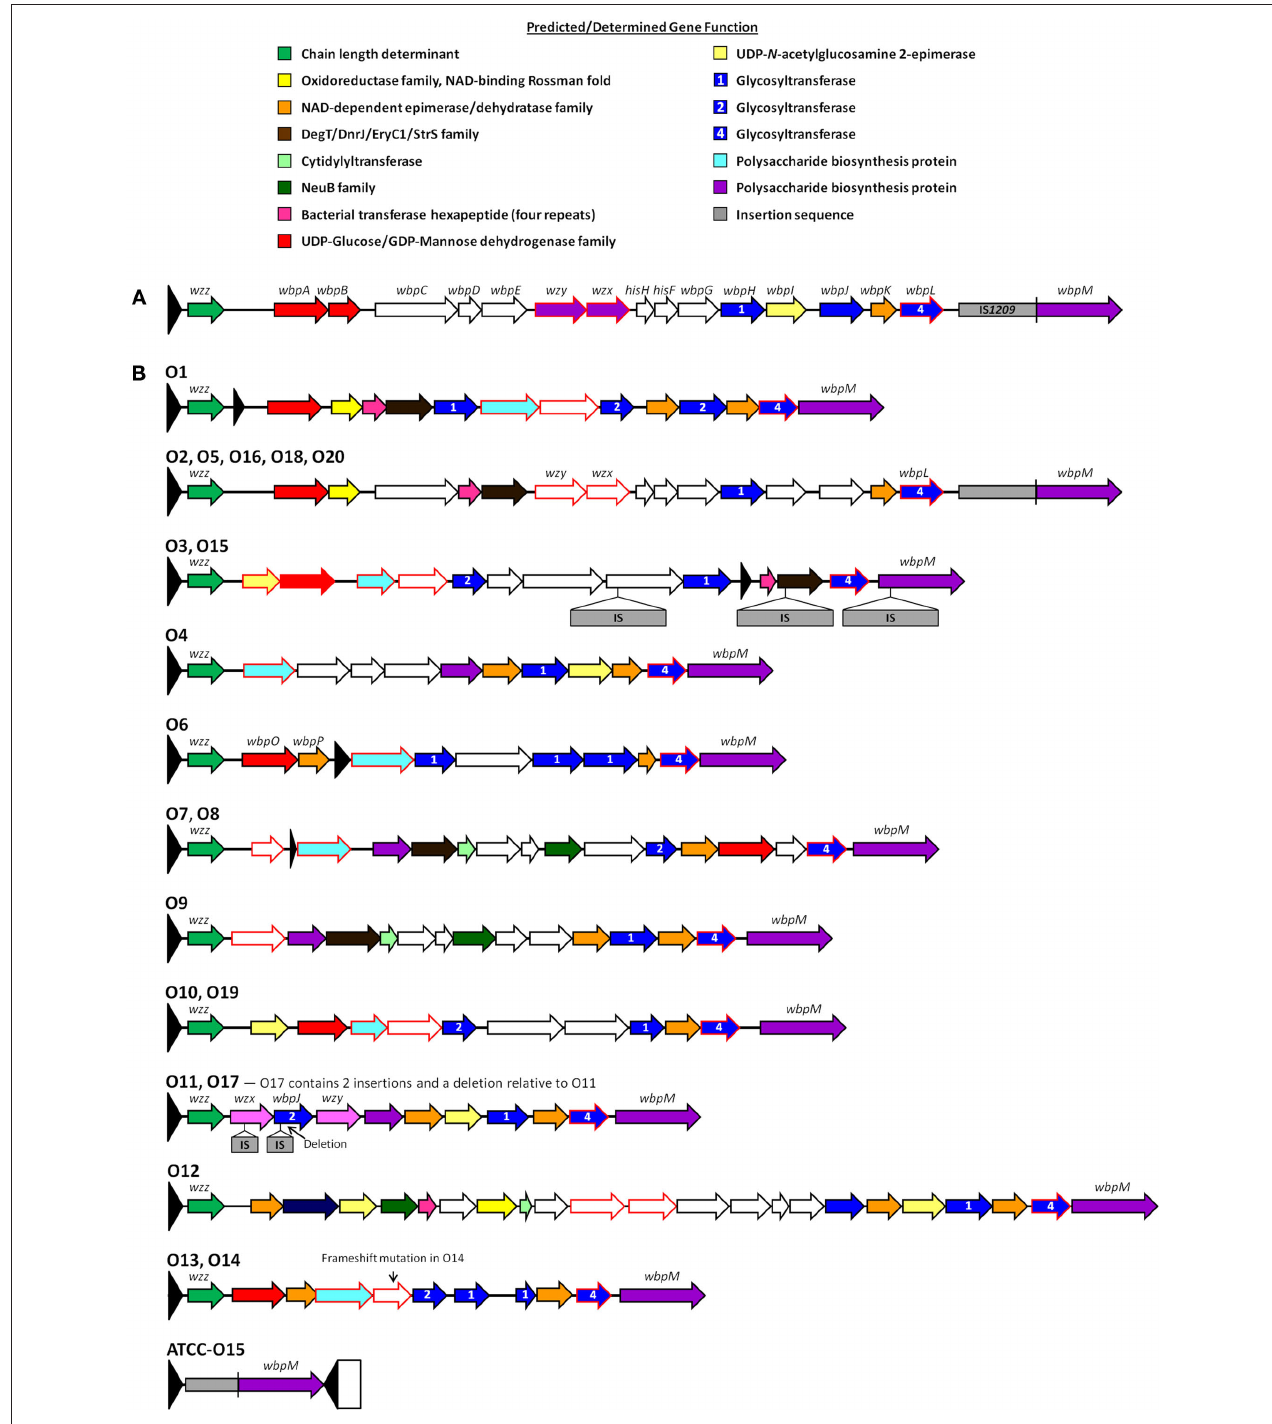
FIgure 2 | Organization of the genes within OSA biosynthesis clusters. (A) OSA biosynthesis cluster of serotype O5 adapted from Burrows et al. (1996). The gene cluster is located on the complementary strand; genes which match the PFAM designation are colored accordingly. Genes not involved in OSA biosynthesis are depicted in gray including a large insertion sequence (IS). (B) Adapted from Raymond et al . (2002), the OSA biosynthesis gene clusters were organized into 11 groups based on sequence